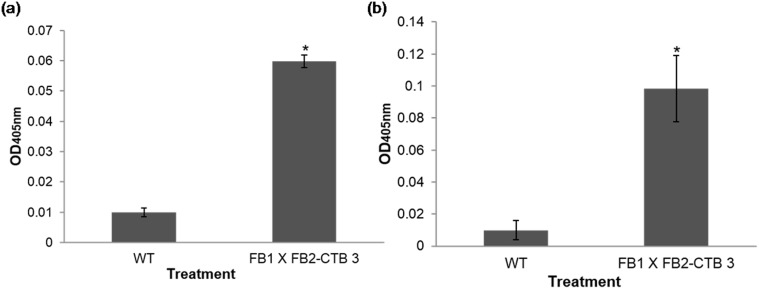
Antibody levels of BALB/c mice immunized with corn smut galls expressing CTB protein.Detection of: (a) anti-CTB IgA antibodies in intestinal washes, and (b) anti-CTB IgG antibodies in sera. Mice immunized with different treatments (biomass from ‘huitlacoche’: FB 1 x FB2-CTB 3 and FB1 x FB2 as control) were bled at day 21, and serum was diluted 1:40. Statistical differences versus the WT group are indicated by an asterisk (P < 0.05).